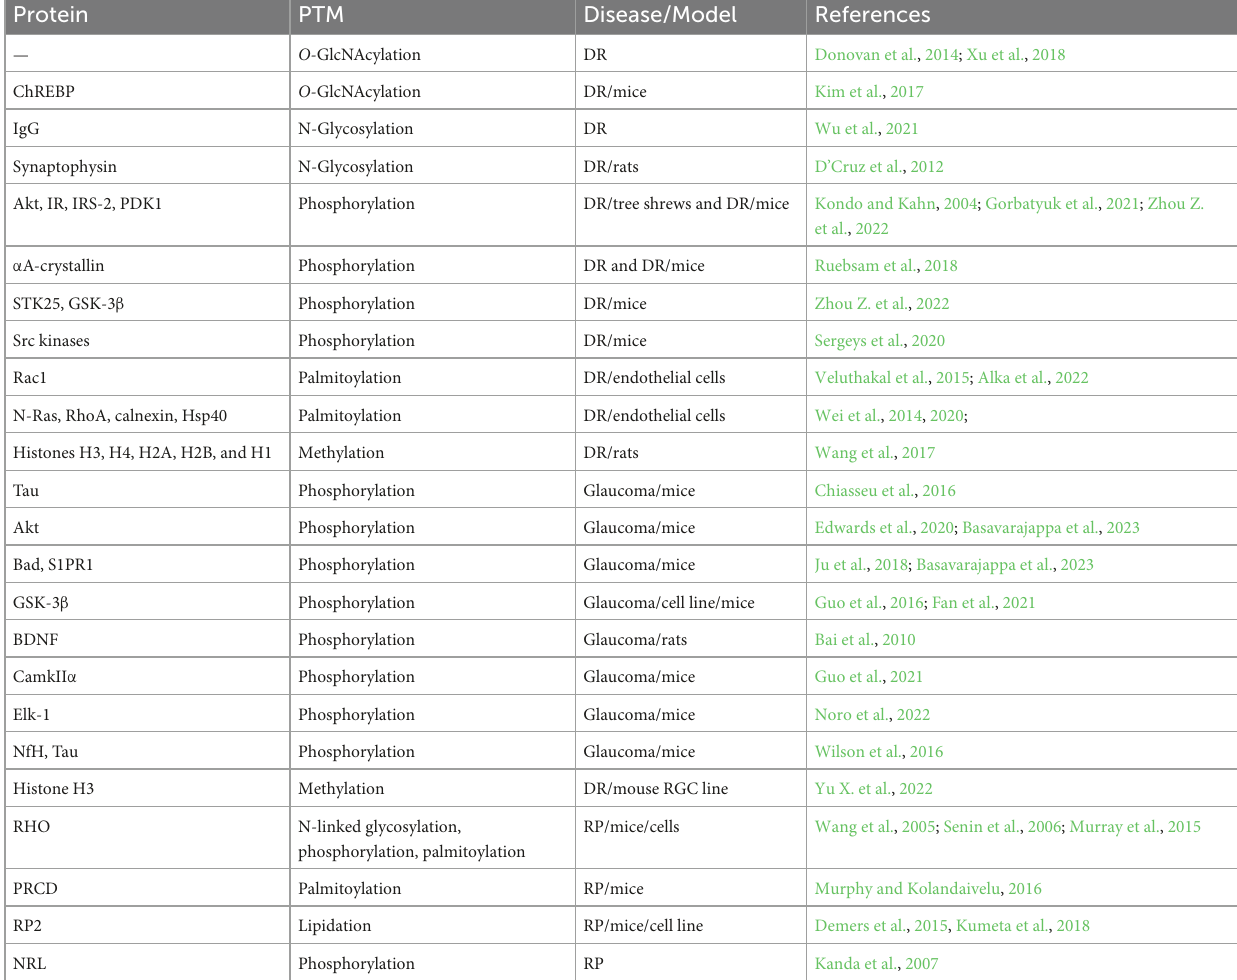
TABLE 1 Summary of referenced PTM